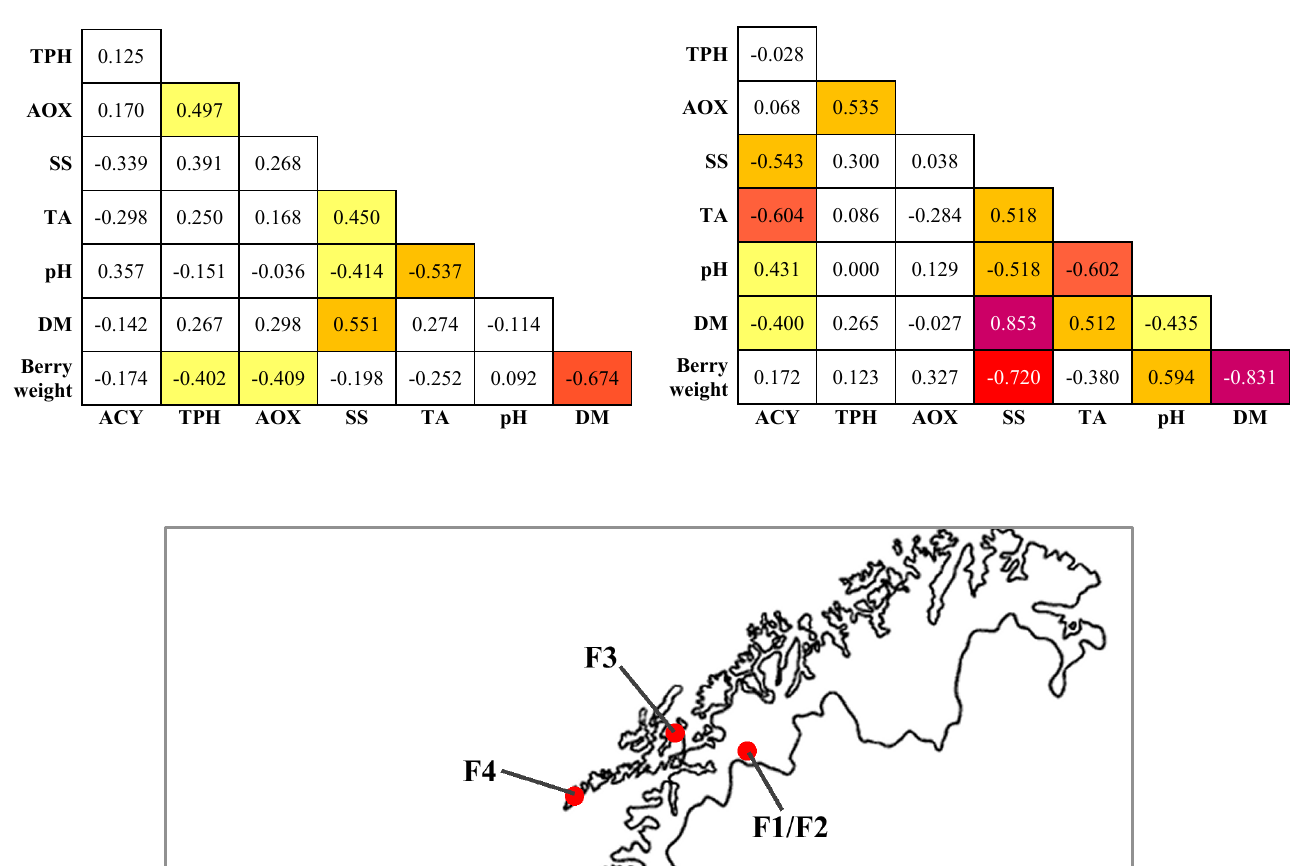
Supplementary Tab. S4: Pearson correlation between quality parameters of Supplementary Table S4. Pearson correlation between quality parameters of berry samples berry samples based on replicate data from single measurements at based on replicate data from single measurements at different harvest time points at trial field F8 different harvest time points at trial field F8 (Tveter). (Tveter).